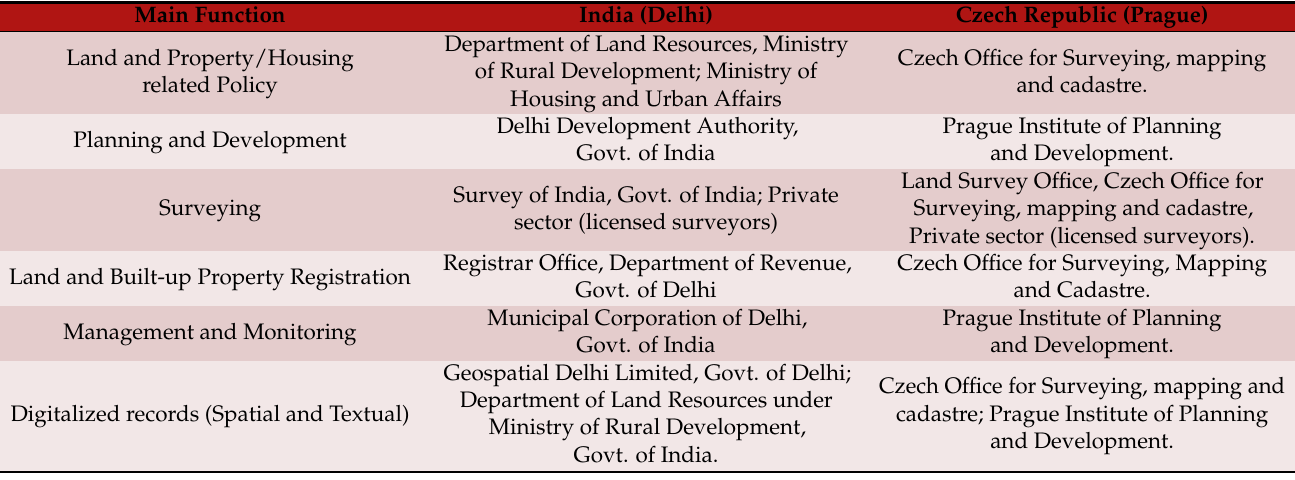
Table 4. Functions of land administration and land management arrangements in India (Delhi) and Czech Republic (Prague). Main